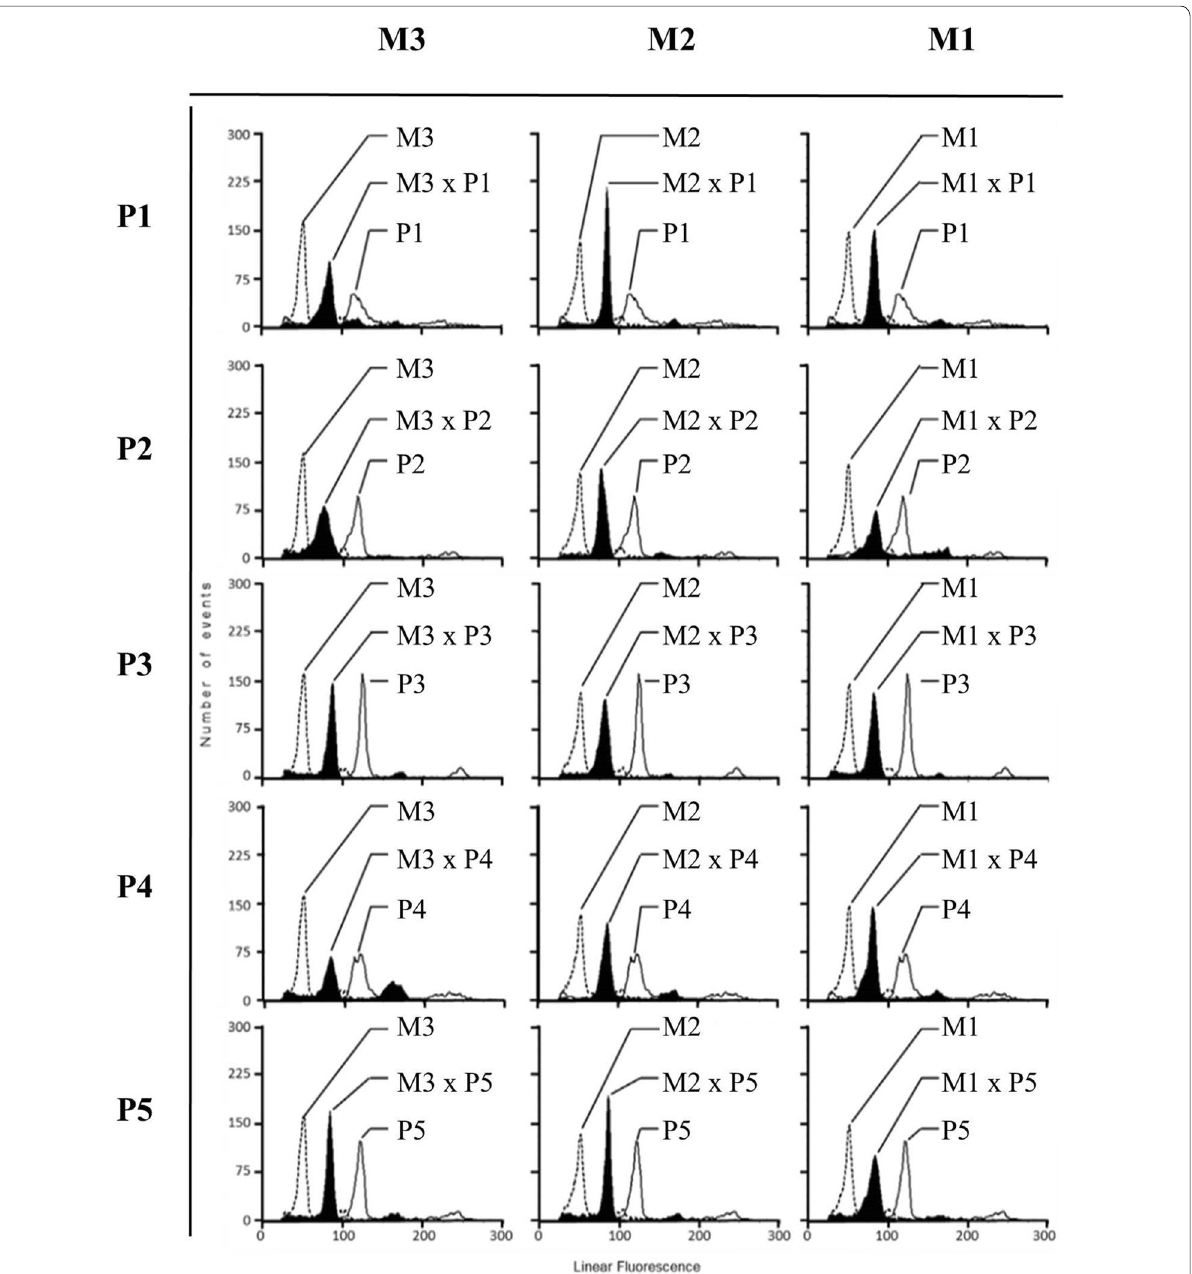
Fig. 1 Relative distribution and fluorescence intensity of B. rapa , B. napus , and F 1 hybrids. M1: “Nongxing 80 days,” M2: “Wansheng rape,” M3: “Edible rape,” P1: “Deza oil No. 18,” P2: “Gueiza No. 4,” P3: “Zhong oil No. 36,” P4: “Wan oil No. 25,” and P5: “FTHEB 1001.” The internals of F 1 hybrids are indicated by the black